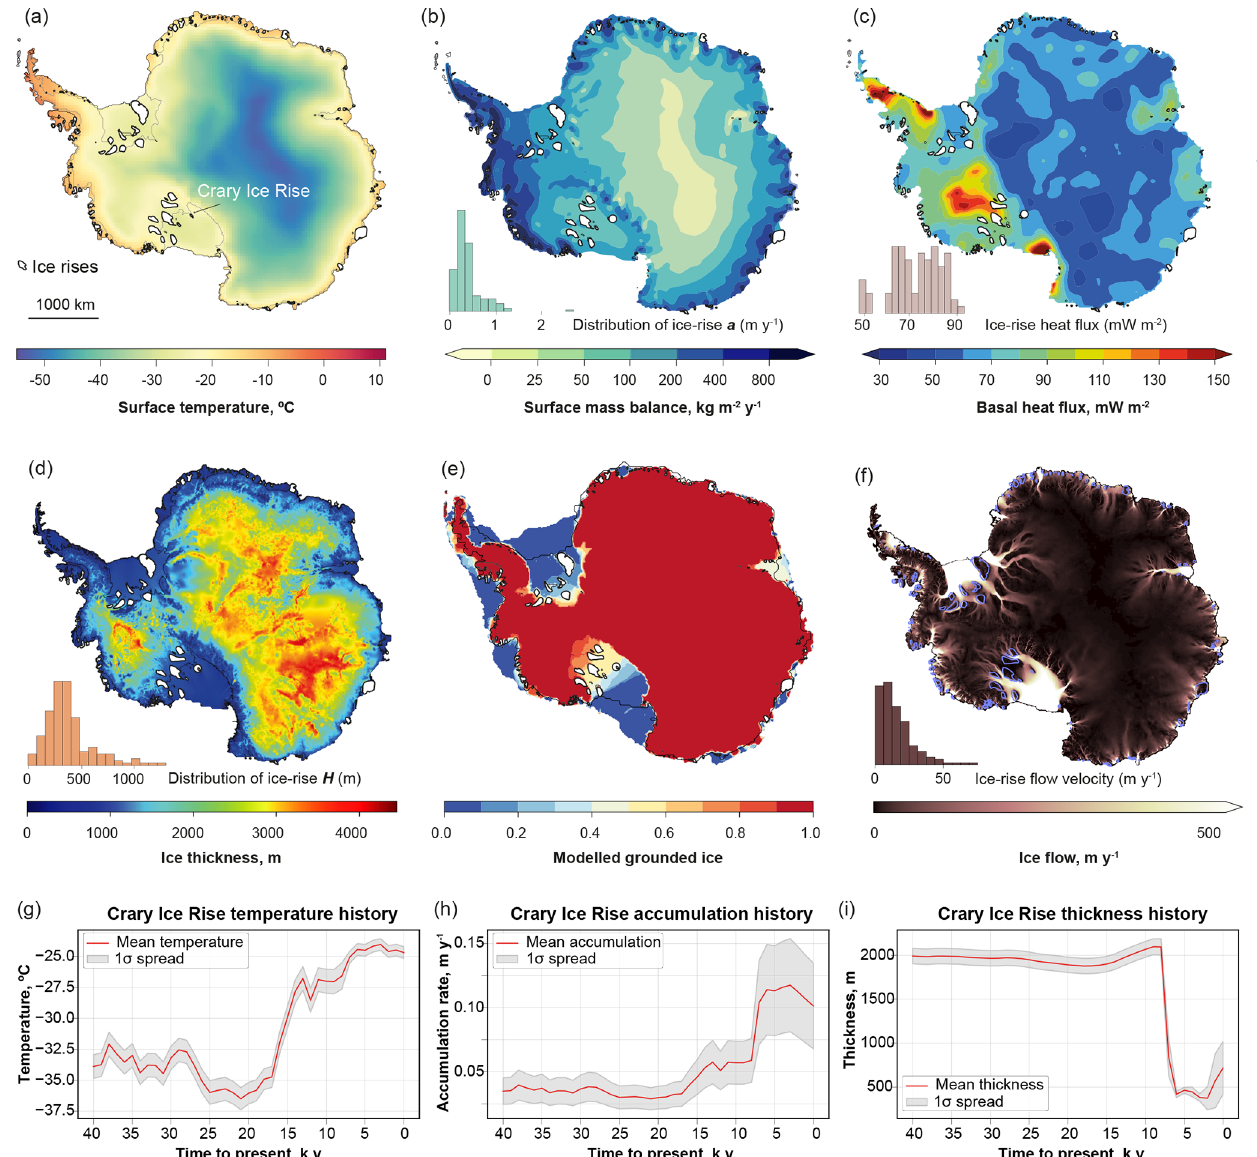
Figure 1. Present-day distribution of key parameters affecting temperature–depth profiles in Antarctica. (a) ERA-Interim annual mean surface temperatures (Albrecht et al., 2020a). White areas in (a) – (e) indicate locations of ice rises from an Antarctic-wide inventory presented in Matsuoka et al. (2015). (b) Mean surface mass balance (that is, the difference between accumulation and ablation at the ice-sheet surface) for the period 1979–2015 (Agosta et al., 2019) and distribution of approximate accumulation rates extracted for all ice rise locations. (c) Basal geothermal heat flux reconstructed from magnetic data (Martos et al., 2017) and distribution of heat flux below ice rises. (d) Ice thickness and ice rise thickness distribution (Fretwell et al., 2013). (e) Ensemble-score-weighted grounded mask for the present-day ice sheet, reflecting possible histories of grounding line migration since deglaciation (Albrecht et al., 2020b). Red colour indicates grounded areas which are covered by grounded ice in all simulations. Blue colour indicates areas which are covered by few simulations with low scores. (f) Ice-flow surface velocity (Arthern et al., 2015). The grounding line and coastlines are shown in black. Arrow on (a) shows the location of Crary Ice Rise, where previously the timing of grounding was inferred using borehole temperature measurements (Bindschadler et al., 1990). (g– i) Forty-million-year histories of surface temperature, accumulation and thickness in the vicinity (i.e. within about 200km) of Crary Ice Rise obtained from large-scale Parallel Ice Sheet Model (PISM) simulations (Kingslake et al., 2018; Albrecht et al., 2020a, b).